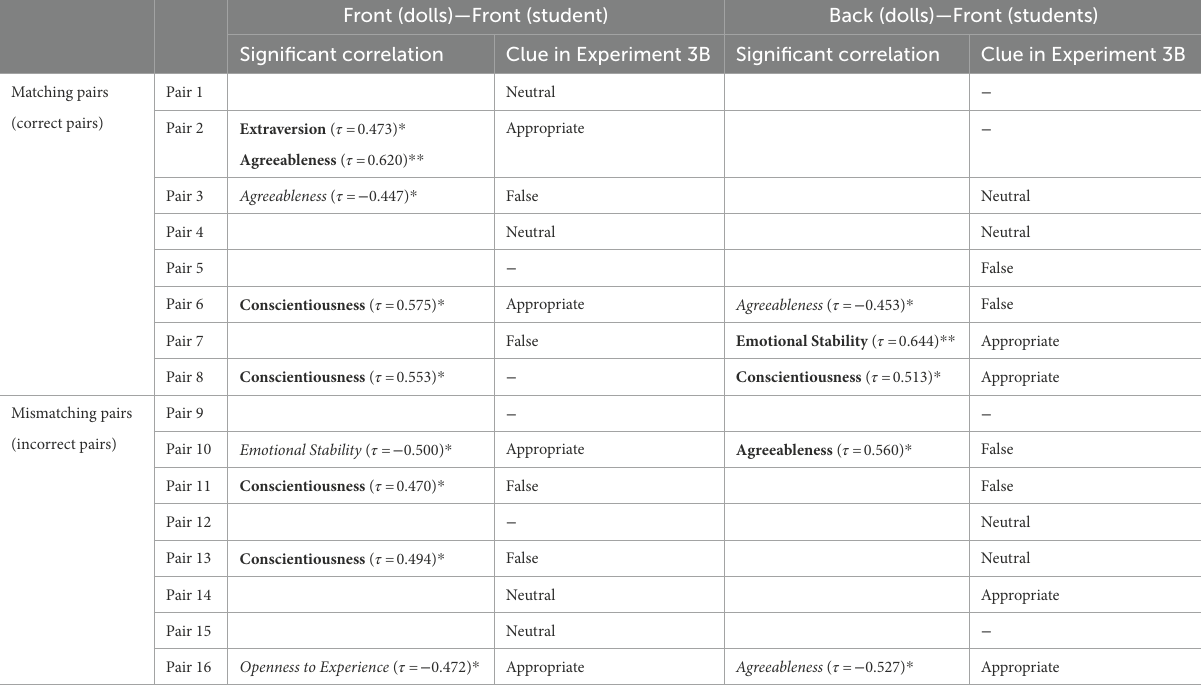
TABLE 1 Significant correlations shown in Experiment 3A and pairs used in Experiment